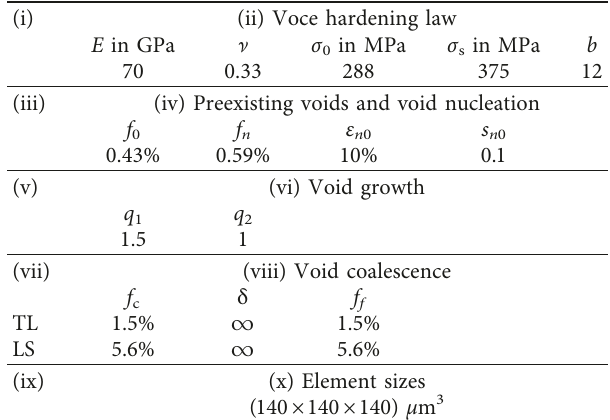
Figure 11: Evolution of mean void volume fraction, averaged through the width of the specimen, in function of the distance in the direction of crack propagation. The two values in red and blue represent the average fraction measured at crack tip (dotted lines in Figure 10). Table 3: Parameters identified for SRCL finite element